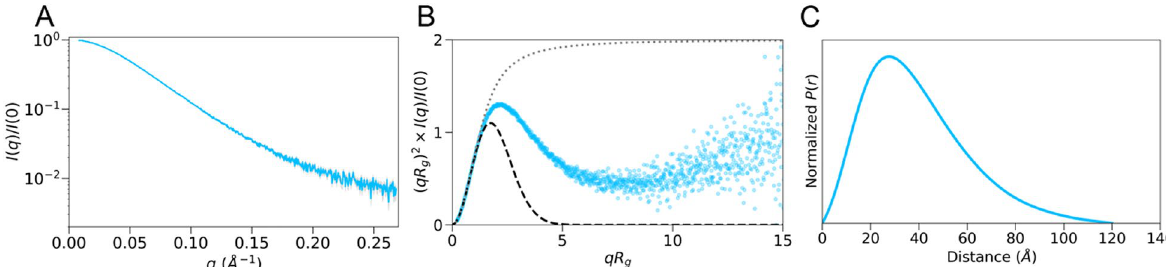
Figure 1. Small angle X-ray scattering analysis of the HOIP RBR domain. ( A ) Scattering plot of observed intensities I(q) versus scattering angles q . ( B ) Dimensionless (normalized) Kratky transformation of the scattering intensities. For reference, a Guinier approximation of globular molecules at low q angles is present as a grey dashed line and plotted as f(x) = x 2 * exp(− x 2 /3) , where x is qR g . The random coil is approximated with f(x) = 2/x 2 [exp(− x 2 ) + x 2 − 1] (grey dotted line), where x is qR g . ( C ) Min–Max normalized p(r) pair distribution RBR/E2 ∼ Ub complexes existed in a conformational equilibrium 23 ⁠ ; (iv) linkers are found to act as protein–protein interaction sites for binding ubiquitin molecules 18,19,24 .